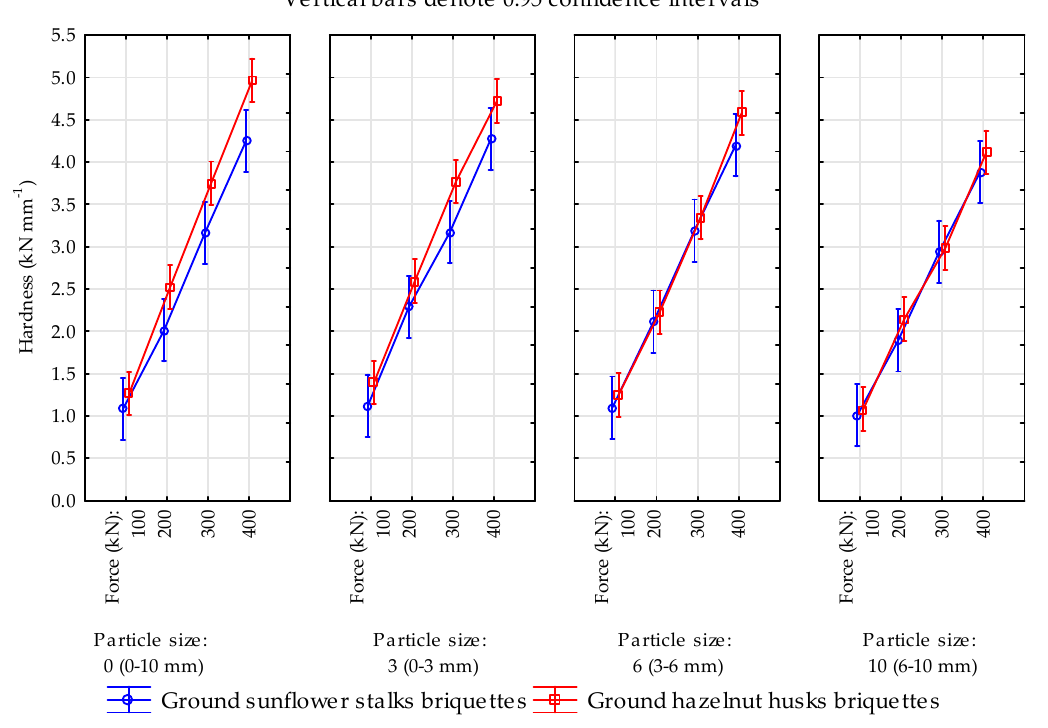
Ground sunflower stalks briquettes Ground hazelnut husks briquettes Energies 2020 , 13 , x FOR PEER REVIEW 12 of 20 Figure 5. Effects of forces and moisture contents on briquette densification energy. Wilks lambda=0.01638, F(36, 50.454)=2.7970, p=0.00040 Vertical bars denote 0.95 confidence intervals